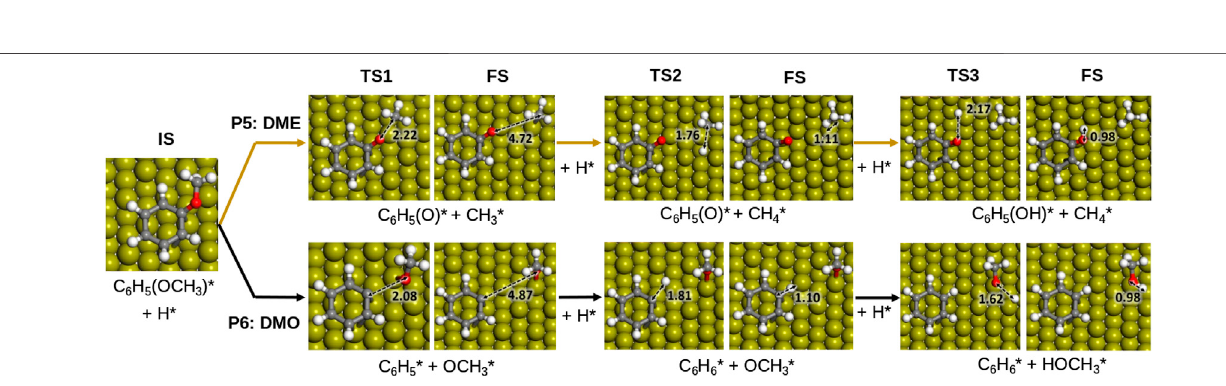
Frontiers in Catalysis |